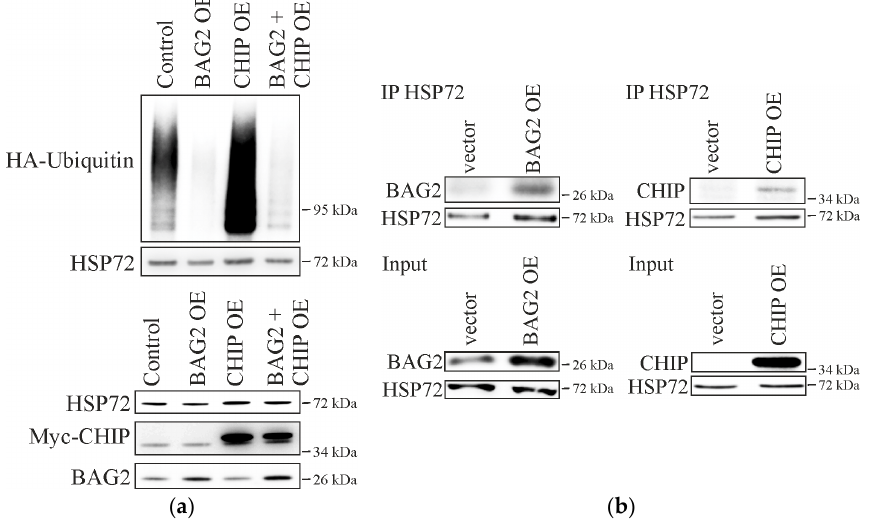
Figure 2. ( a ) Fibroblasts were transiently transfected with HA-tagged ubiquitin and either EGFP as control, or BAG2 or myc-CHIP, or BAG2 and Myc-CHIP. Endogenous HSP72 was immunoprecipitated and the level of ubiquitination was monitored by anti-HA antibody. Purified mouse IgG was used as negative control (not shown). The lower panel shows protein levels in total cell lysates used for Co-IP (Input); ( b ) Cells were transfected with HA-tagged ubiquitin together with either BAG2, Myc-CHIP or EGFP as control. Endogenous HSP72 was immunoprecipitated and BAG2 or myc-CHIP were detected by specific antibodies. The lower panels show protein levels of the analyzed proteins in total cell lysates used for Co-IP (Input). CHIP: C-terminus of HSP70-inteacting protein, STUB1; OE: overexpression; HA: hemagglutinin.